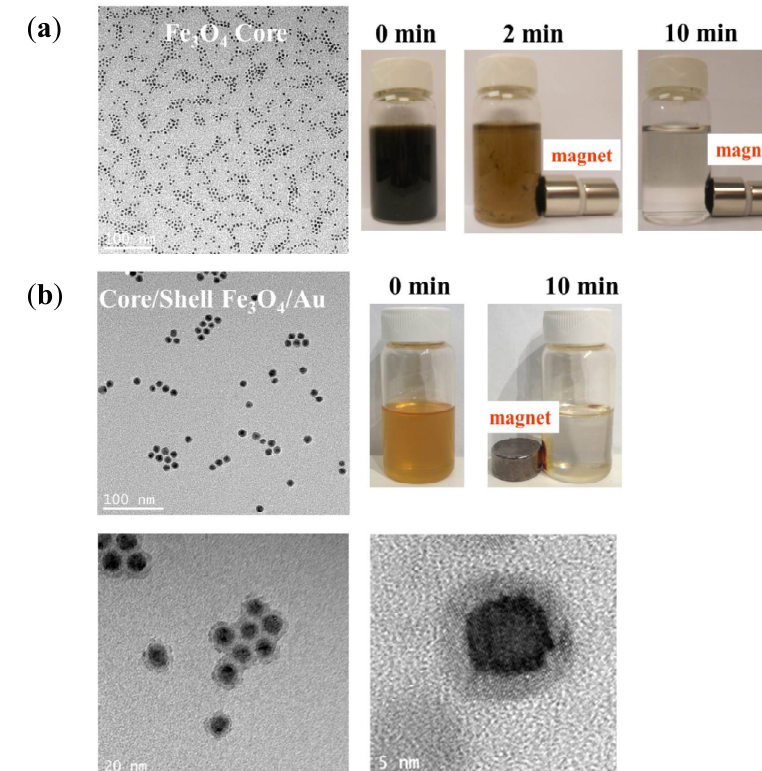
O /Au core/shell NPs at different 3 4 O appears dark in the center. 3 4